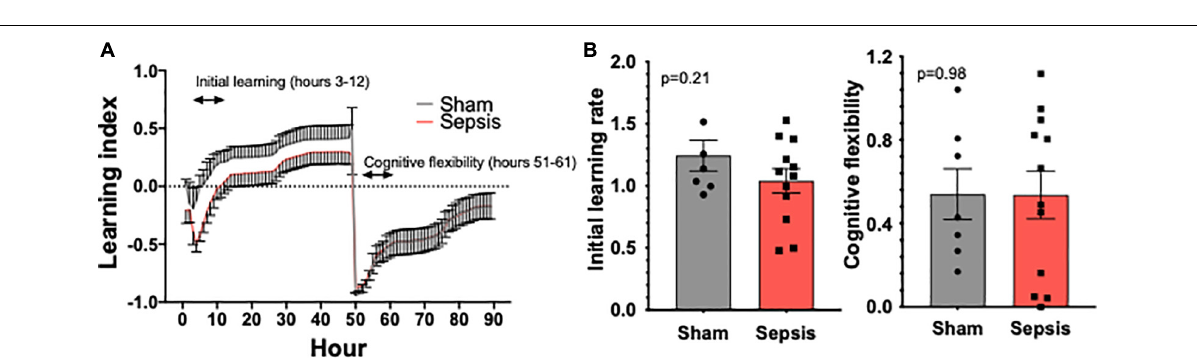
FIGURE 4 | Sepsis effects on cognitive performance in aged animals. PhenoTyper homecage system was used to evaluate the impact of sepsis on cognitive performance ( n = 13 in sepsis group and n = 7 in sham group). (A) All experimental animals were tested for the duration of 4 days, during which Initial Learning and Cognitive Flexibility were evaluated. Our data demonstrate a trend toward an impairment of cognitive performance measured during the initial learning phase (B) . Cognitive flexibility was unaltered by